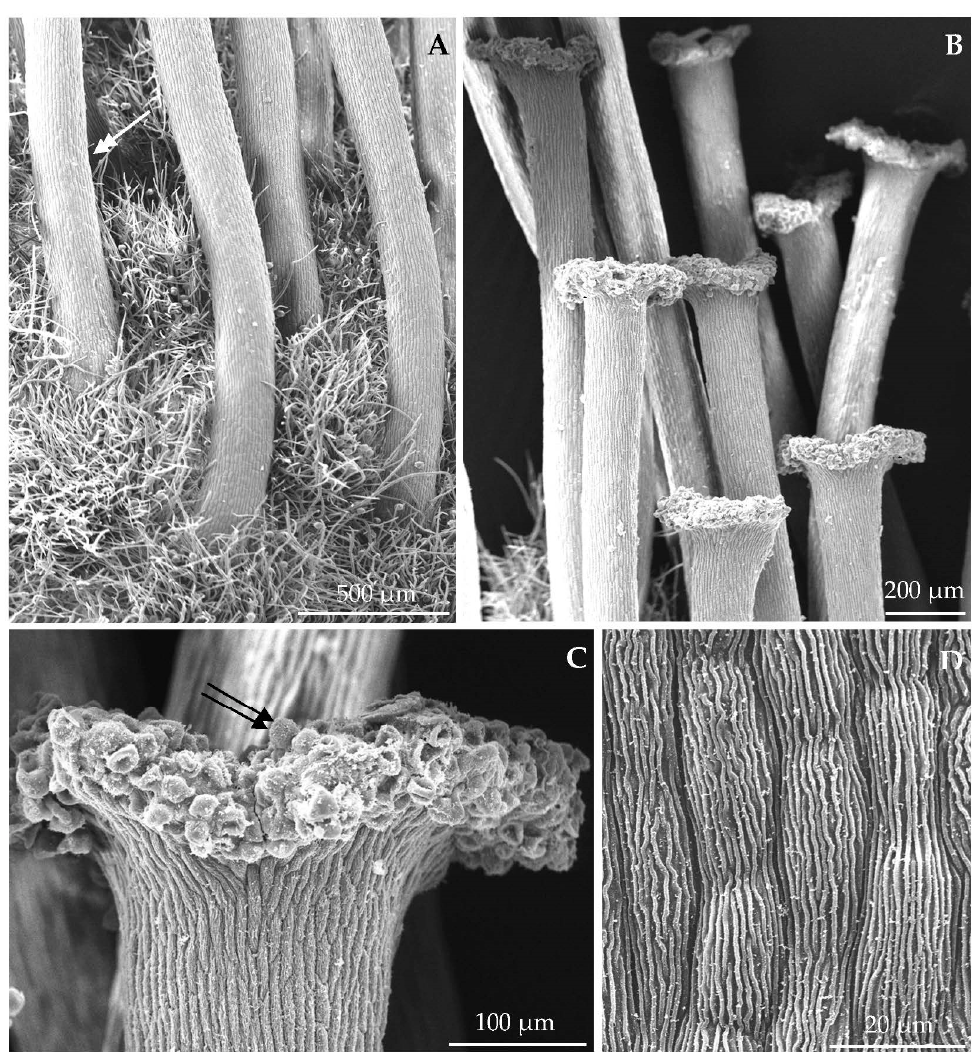
Figure 4. ( A – D ). Fragments of the epidermis on the ovary ( A ), style ( A – D ), and stigma ( C ) in R. idaeus ‘Polana’ ( A ), ‘Polka’ ( B , C ), and ‘Glen Ample’ ( D ) in the initial secretion phase. ( A ): non-glan- dular trichomes on the ovary epidermis; basal part of pistil styles (double-headed arrow). ( B ): upper part of styles; stigmata (asterisks) dilated beyond the style margin. ( C ): papillae on the stigma surface (two arrows). ( D ): striated cuticular ornamentation on the pistil surface; distinct cuticular striae in parallel arrangement, sometimes bending delicately or overlapping.